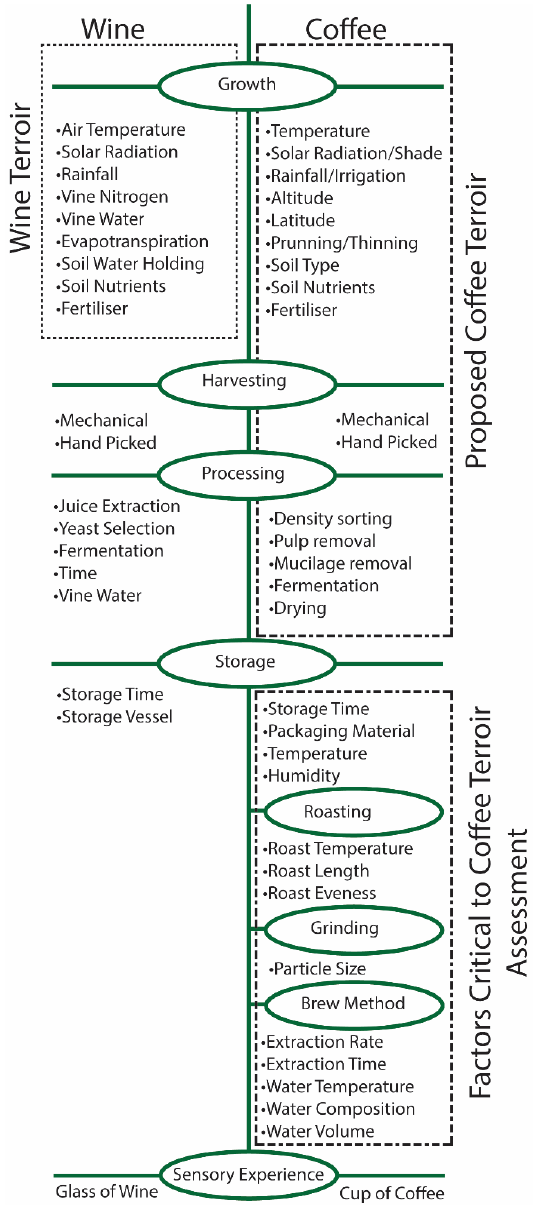
Figure 1. A comparison of the steps required before the terroir of wine or coffee is assessed, with wine terroir defined [7] and coffee terroir proposed.